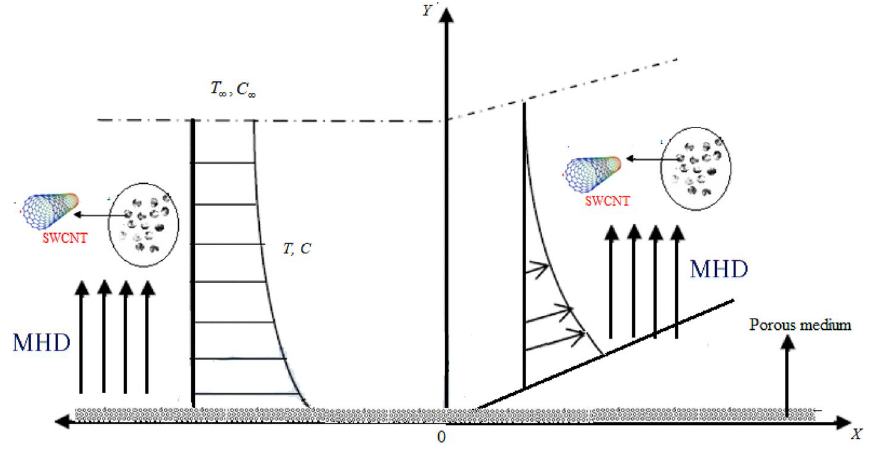
Figure 1. Schematic diagram of the Casson fluid